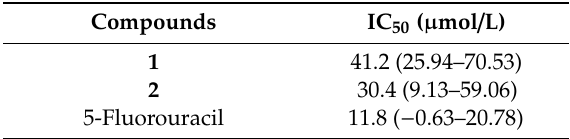
Table 4. The human gastric cancer cell inhibitory activities of